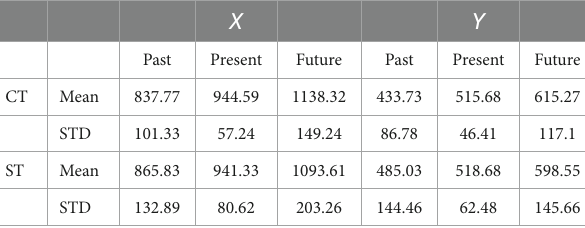
The inter-participant pattern of the distribution of time zones described above showed no difference in how Z positions were used were used to draw the three spheres. Does this mean that the Z axis was not used in the ST? The histograms in Figure 6 show the frequencies of the range over which three spheres were distributed.